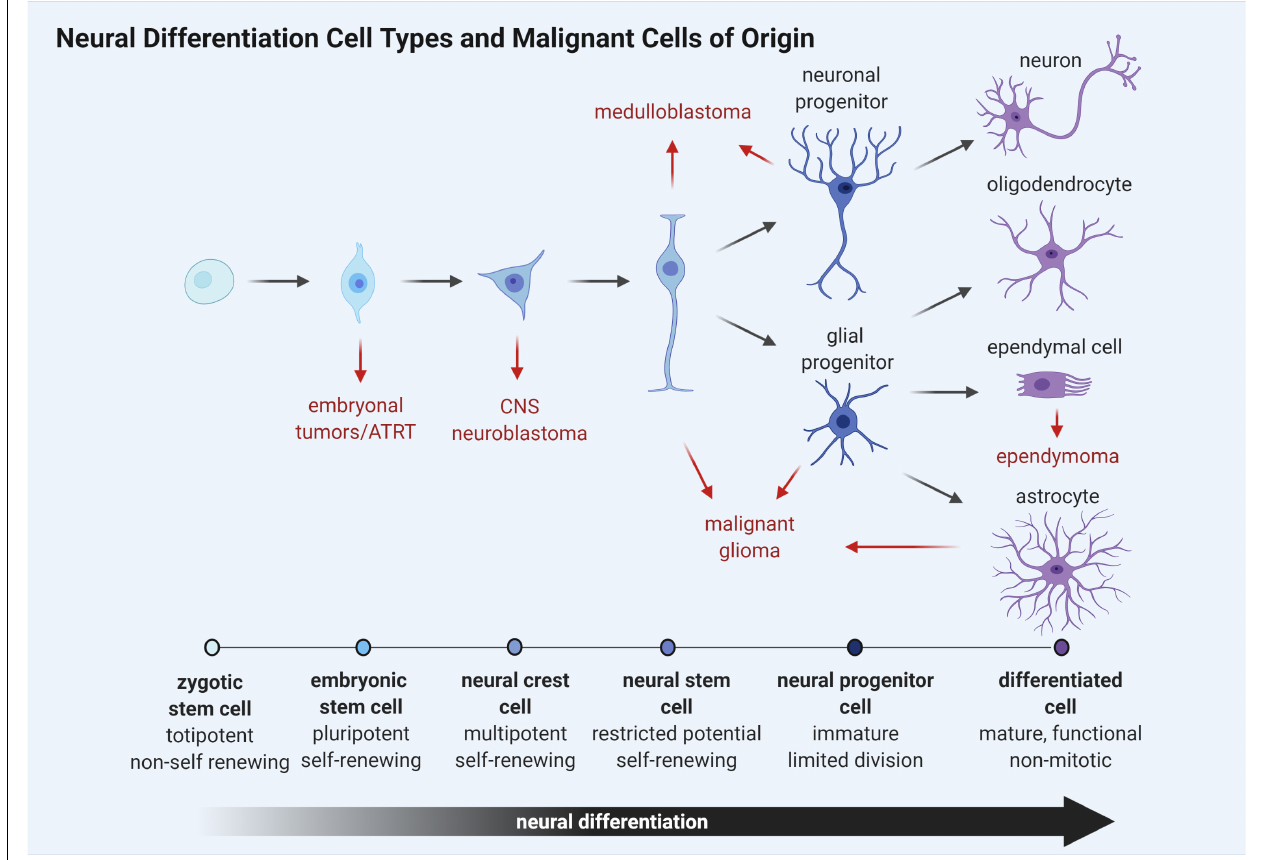
FIGURE 2 | Schematic representation of neural cell differentiation in development. As cellular differentiation ensues, proliferative capacity is inversely reduced until terminal differentiation is reached and cells become senescent. Brain tumor subtypes are listed adjacent to the cell type most closely resembling a putative cancer cell of origin (red